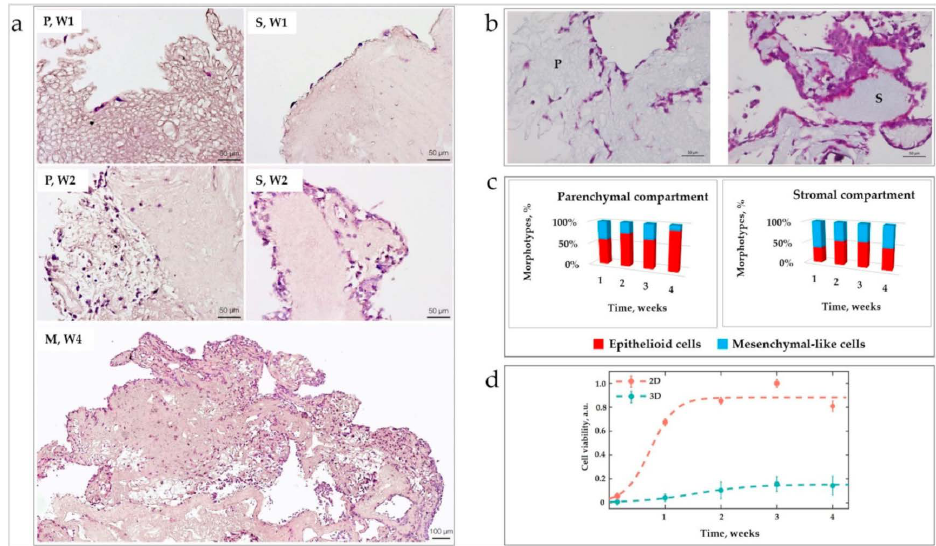
Figure 6. ( a ) Representative histological images of cellular colonization of the liver AOSSs during four weeks of in vitro culture (time points are labeled as W1, W2, and W4 for the first, second, and fourth weeks, respectively). The images of parenchymal and stromal compartments are labeled as “P” and “S,” respectively. “M” labels the remodeled ECM with mixed parenchymal and stromal features. Staining with H&E, the scale bars are 50 µ m (top and middle rows) and 100 µ m (bottom row). The top row shows the colonization patterns on the 5th day in vitro. Note sparse individual cells that are attached to the loose spongy-like parenchymal ECM on the outer border of the TEC (on the left). In contrast, formation of a discontinuous lining is visible on the dense ECM of the stromal compartment (on the right). Middle row, Day 13 in vitro: Note the colonization of the parenchymal compartment (P, W2) (the fragment with loose structure near the surface of AOSSs) by individual cells and predominantly single-cell invasion to the stromal ECM. A few small multicellular clusters showing predominant single-cell invasion in the deeper parts of the scaffold are visible on the border with the area composed by the stromal ECM. In parallel, in the stromal ECM compartment (S, W2): The continuous multi-row cell lining on the stromal ECM with minimal invasion is observable. Bottom row (M, W4): Remodeling of the ECM of stromal origin and massive diffuse colonization of the whole scaffold (day 28). ( b ) Parenchymal (P) and stromal (S) compartments of the CE liver ECM—TNBC 3D TECs on week 2. Staining by Masson’s trichrome method. Note similar tinctorial properties (light blue staining indicating comparable concentrations of collagen) and different distribution of the cells (stained purple) over the compartments. There are lower cell numbers and deeper invasion of individual cells in the parenchymal sector and formation of dense cellular clusters near the surfaces (with shallow invasion depth of cell collectives) in the stromal compartment. Scale bars, 50 µ m. ( c ) Effect of parenchymal and stromal LS-ECM on cell morphology. Distribution of the epithelioid and mesenchymal-like cellular morphotypes in LS-ECM compartments during four weeks of in vitro culture in TECs. ( d ) Cell growth dynamics of MDA-MB-231 cells in 2D and 3D (TEC) in vitro cultures. Dashed curves represent the lines of best fit given by Equation